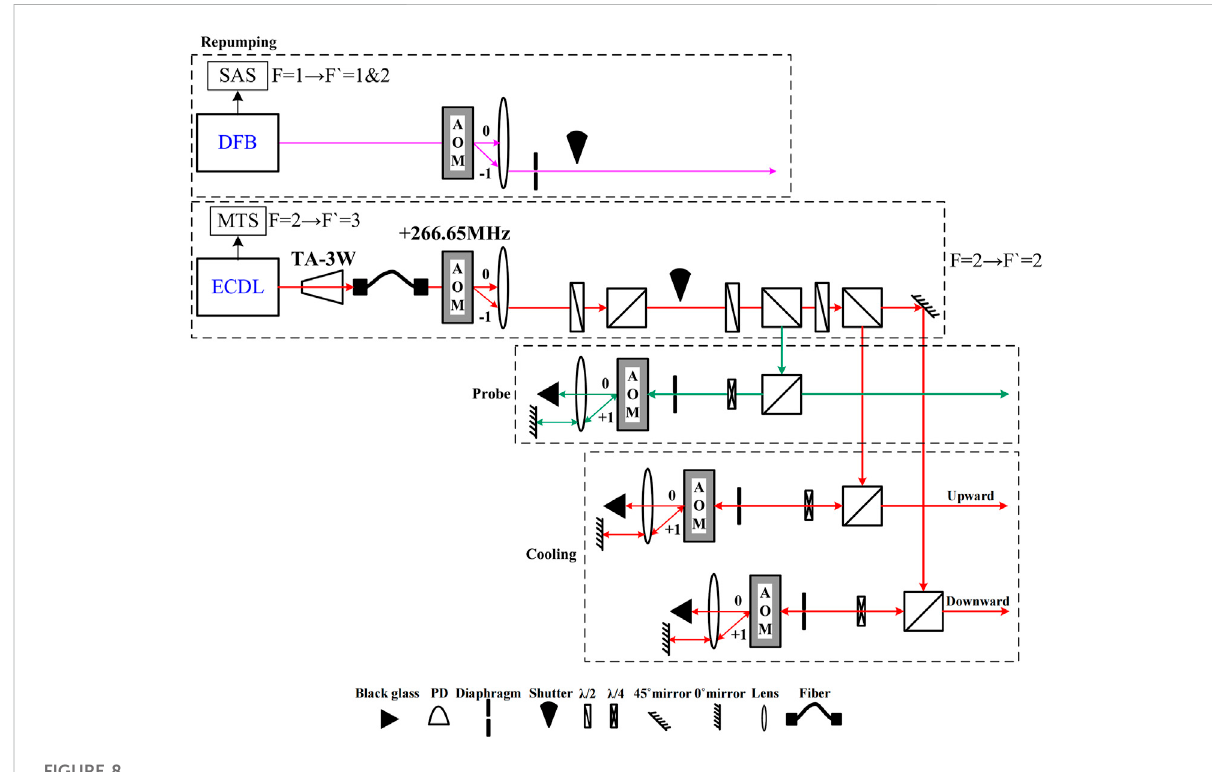
FIGURE 8 The schematic diagram of the optical path for laser cooling.